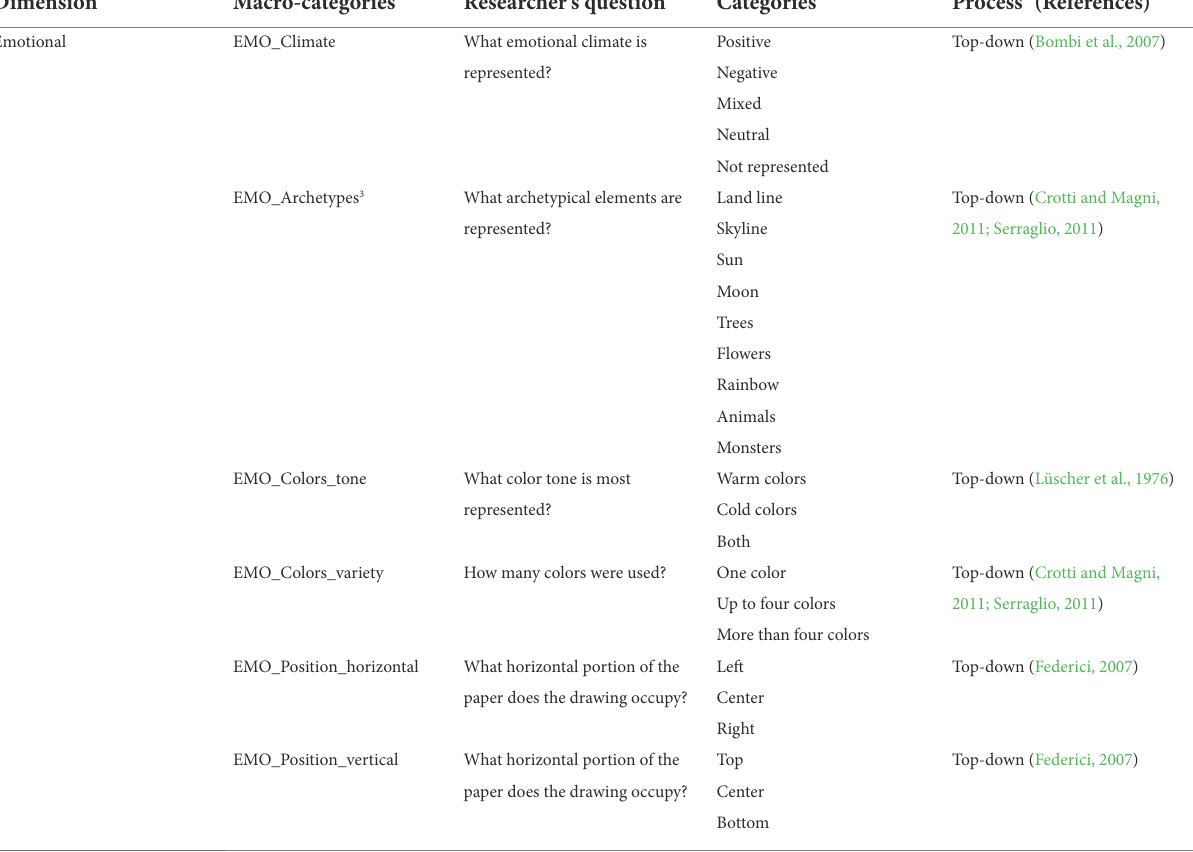
TABLE 4 Emotional dimension: macro-categories and categories included in the DRAW.IN.G. grid. Dimension